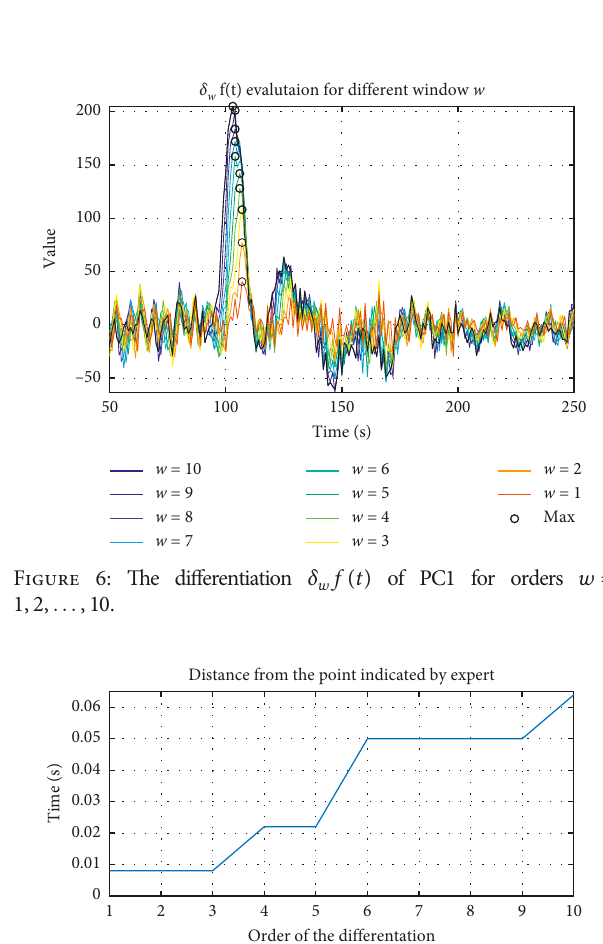
Order of the Figure 7: The difference between the P-wave arrival time according to the expert opinion and the P-wave arrival time detected by the proposed method depending on the δ w .